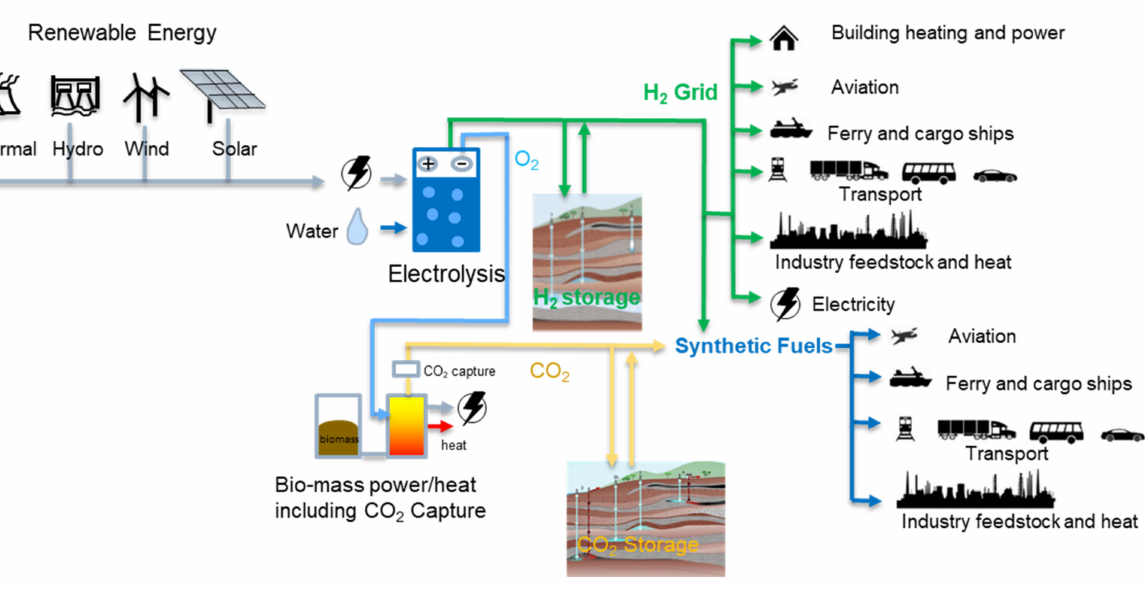
the right part of Figure